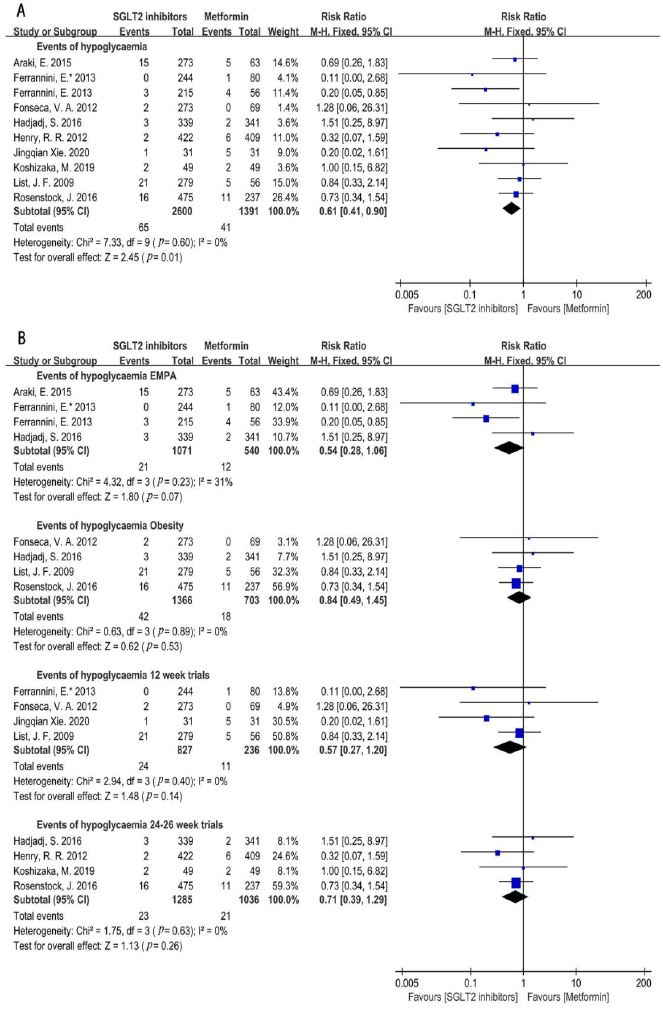
Figure 16. ( A ). Risk of hypoglycemia in SGLT2i group compared with that of metformin [20–25,29–32]. ( B ) Risk of hypoglycemia between the two groups in different subgroups [20–25,29–32]. EMPA = em- pagliflozin, 12 weeks trials = SGLT2i used 12 weeks, 24–26 weeks trials = SGLT2i used 24–26 weeks. Obesity = SGLT2i used in obese